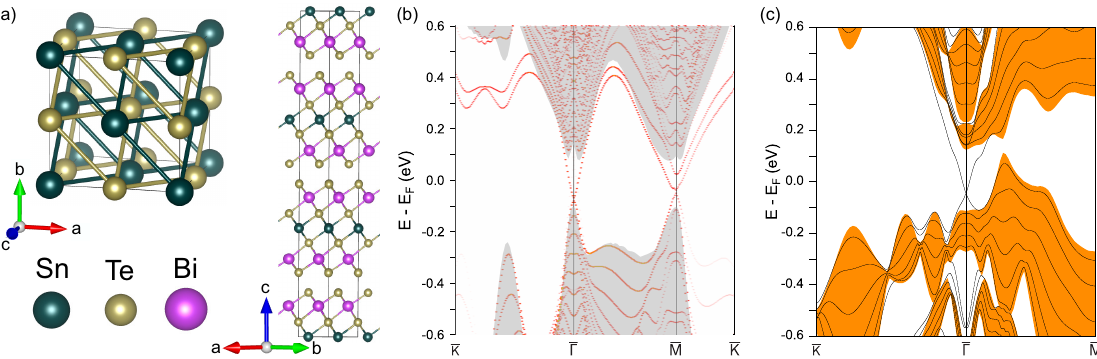
Figure 1. Crystal structure of bulk SnTe (left panel) and SnBi 2 Te 4 (right panel) ( a ). Surface electronic structures of the nonpolar SnTe(111) ( b ) and SnBi 2 Te 4 (0001) ( c ). The grey (orange) background corresponds to the SnTe (SnBi 2 Te 4 ) projected bulk band